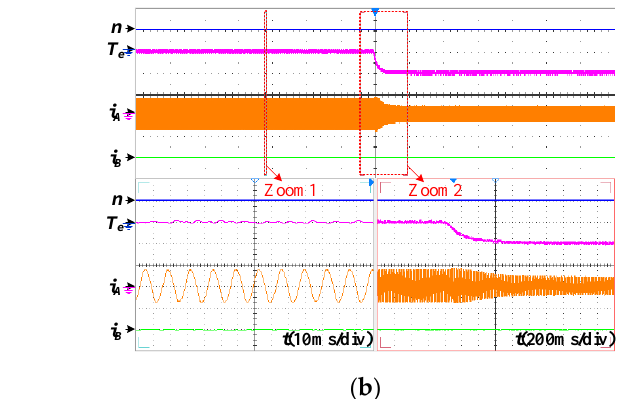
Figure 10. Dynamic responses with the reduced load at phase-A open-circuit fault-tolerant opera- tion. (500 rpm/div, 2 Nm/div, 5 A/div). ( a ) ( b ) Figure 11. Experimental results in normal operation, fault operation, and two-phase open-circuit fault-tolerant operation. (2 Nm/div, 5 A/div). ( a ) BE two-phase open-circuit fault. ( b ) CD two-phase open-circuit fault. 6. Conclusions Based on the analysis of the problems existing in the conventional fault-tolerant vec- tor control strategy, a fault-tolerant FOC strategy based on disturbance adaption was de- veloped for the five-phase FTPMSM under an open-circuit fault circuit. The following ad- vantages of the proposed fault-tolerant FOC strategy were obtained: